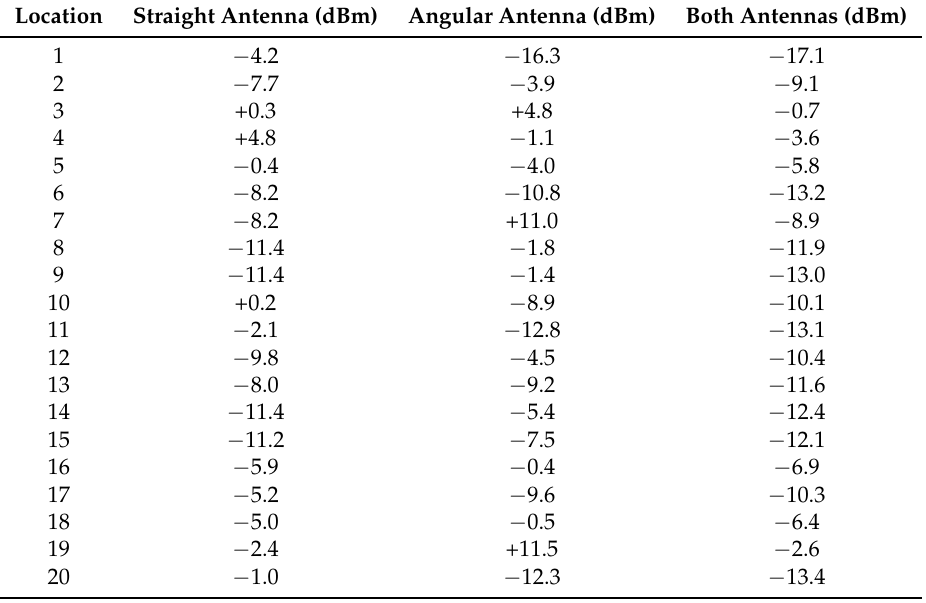
Table 3. Required sender power to wake-up the receiver measured at 20 different multipath locations and different antenna configurations.